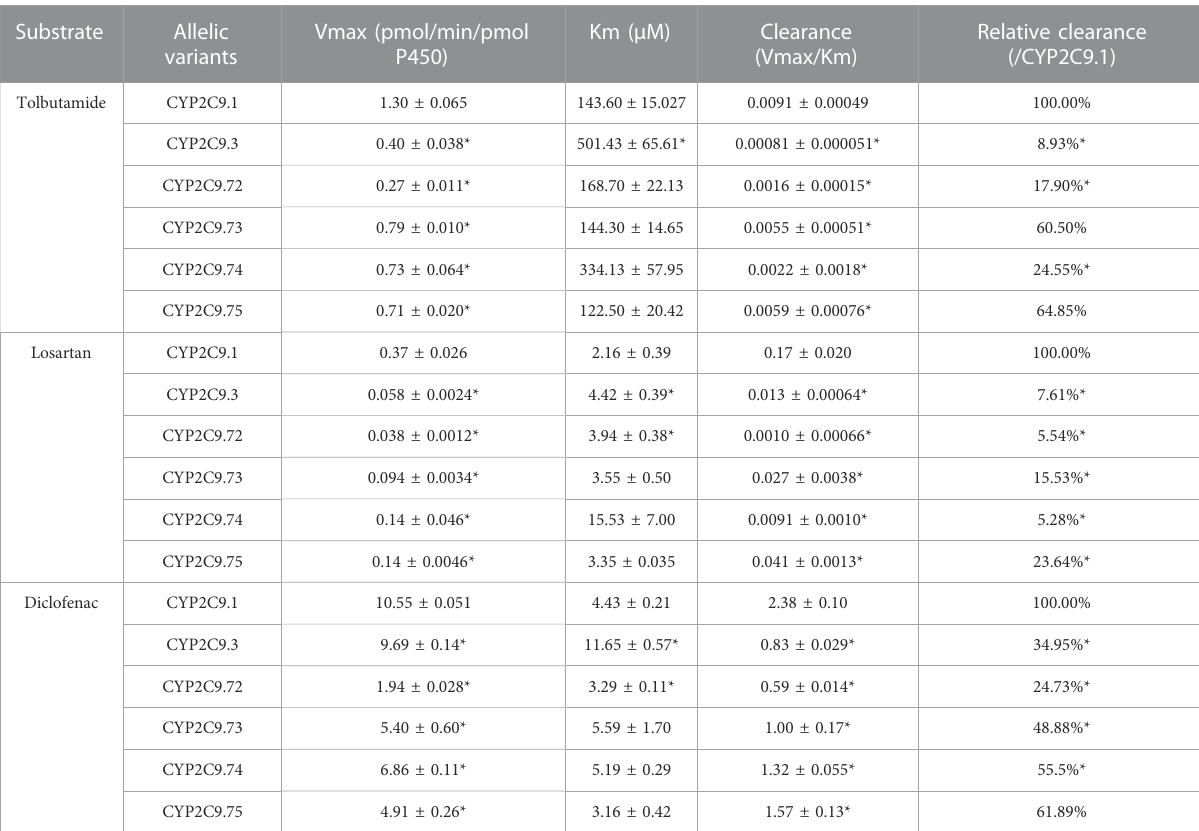
TABLE 4 Enzyme kinetic values of recombinant wild-type and CYP2C9 variants.